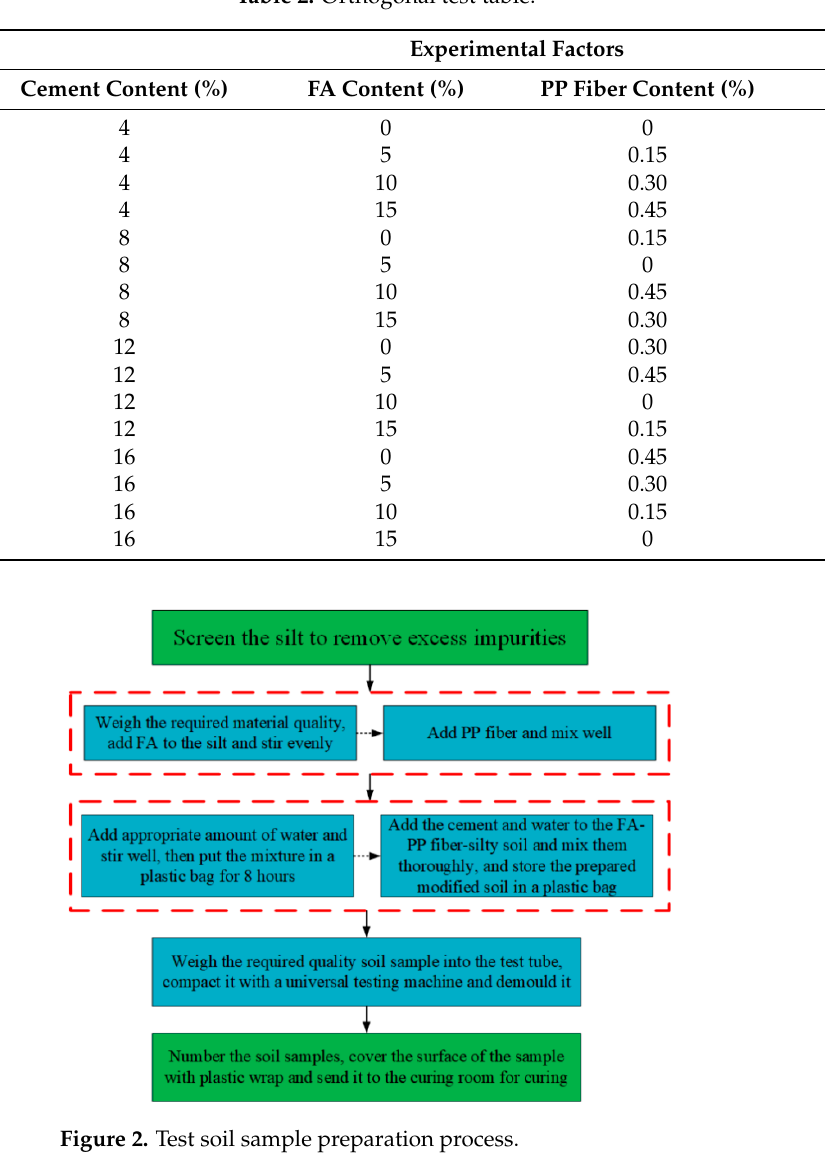
Table 2. Orthogonal test table.